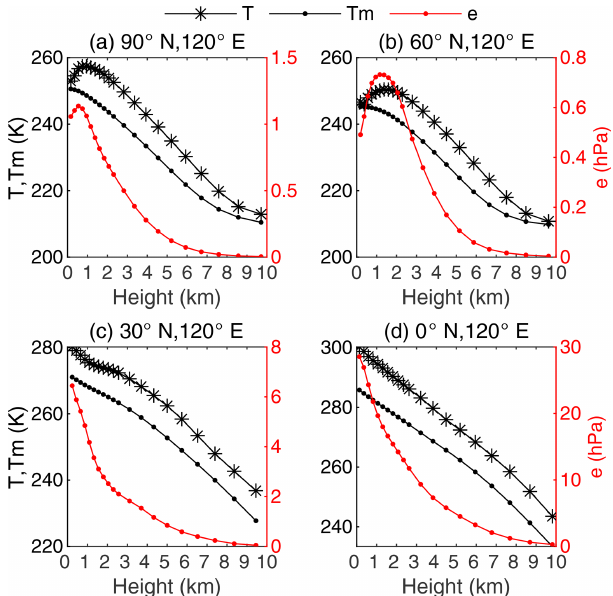
Figure 1. Temperature T , water vapor pressure e , and T m profiles obtained from ERA5 monthly mean reanalysis in December 2017 at four grid points: (a) 90 ◦ N, 120 ◦ E; (b) 60 ◦ N, 120 ◦ E; (c) 30 ◦ N, 120 ◦ E; (d) 0 ◦ N, 120 ◦